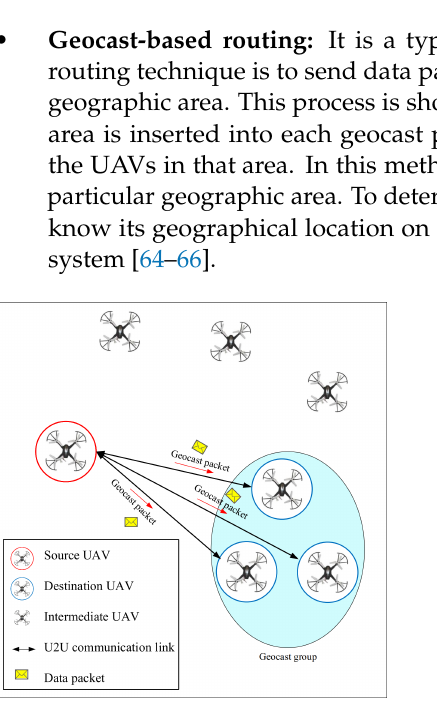
Figure 25. Geocast-based